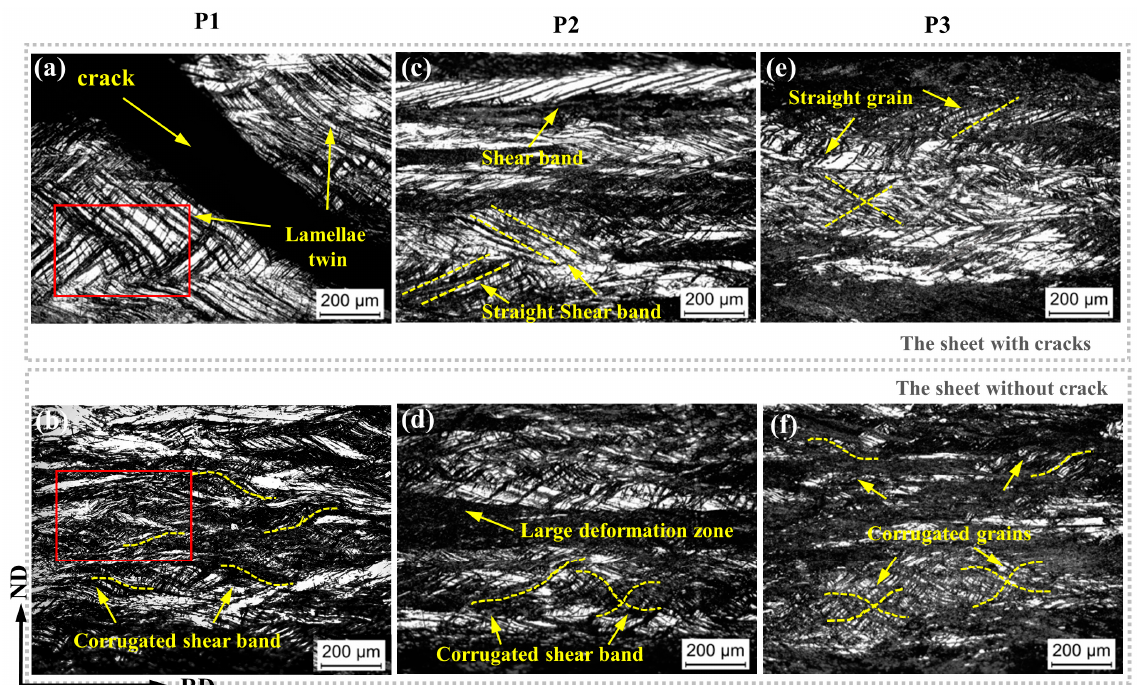
Figure 4. Microstructure evolution from the edge to the center of the sheets. The yellow arrows indicate twins, cracks, dislocations, and shear bands. ( a ) At P1, ( b ) at P2 and ( c ) at P3 of the sheet with cracks. ( d ) At P1, and ( e ) at P2 and ( f ) at P3 of the sheet without cracks.